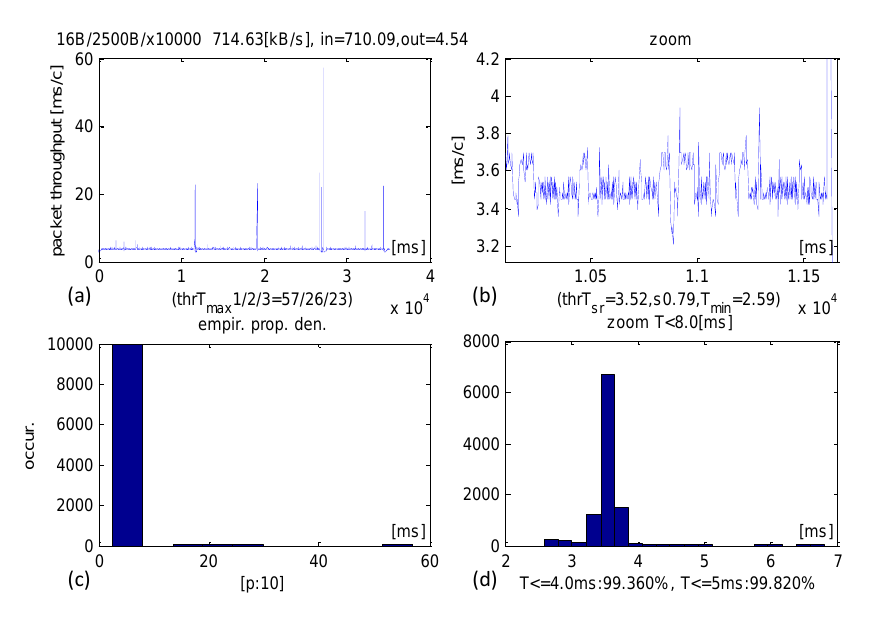
Figure 7. Experimental results of CCLT for packets IN = 2500 B. ( a ) Recorded